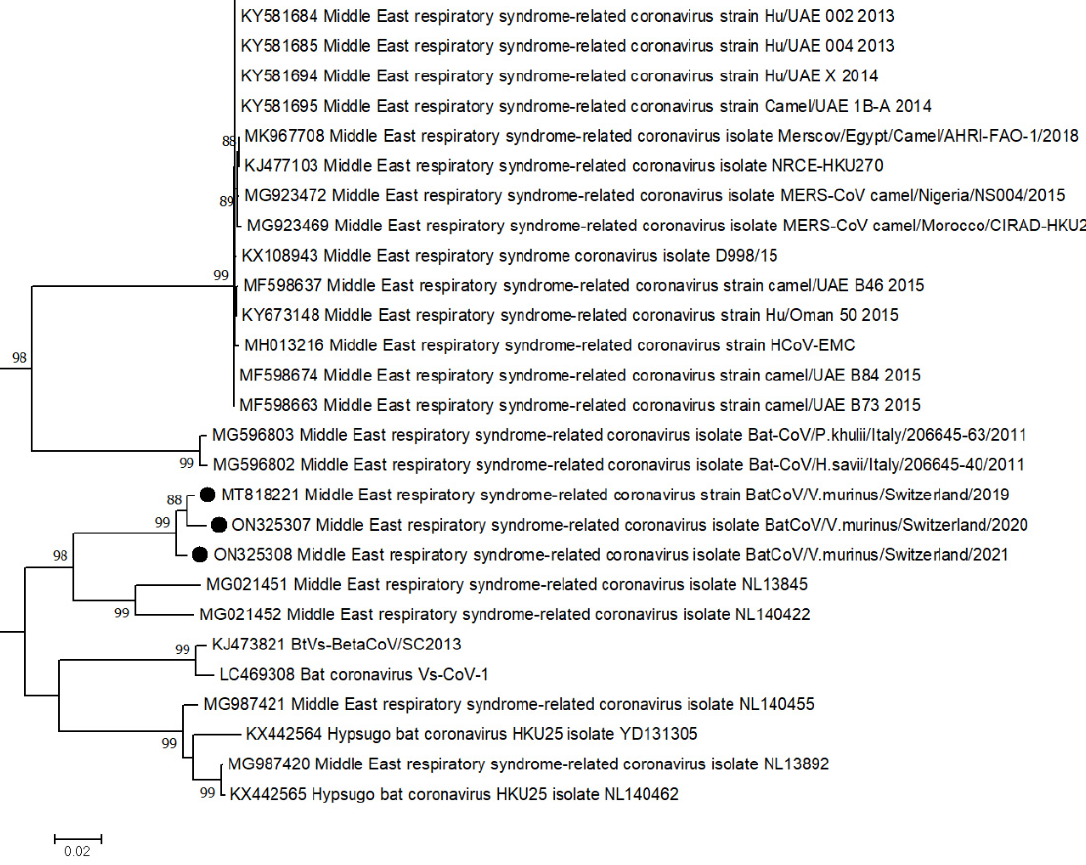
Figure 3. Phylogenetic tree based on nucleotide sequence identity of the NS12 protein (which includes RNA-dependent RNA polymerase ( RdRp )) of selected beta-coronaviruses. Sequences found in this study are marked by black dots. Phylogenetic analysis was performed using the Maximum likelihood algorithm based on the Tamura–Nei model with the 1000 replications bootstrap method. Only values ≥ 70% are displayed. Evolutionary analyses were conducted in MEGA X.